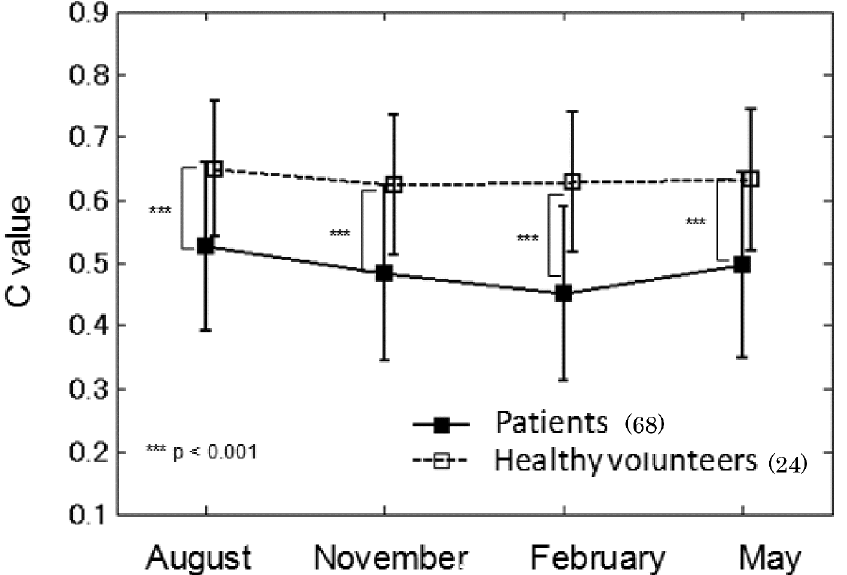
Fig 3. Time course of same-finger C values for images compared with those first acquired in June. Mean values plus/minus one standard deviation are plotted. *** p < 0.001.